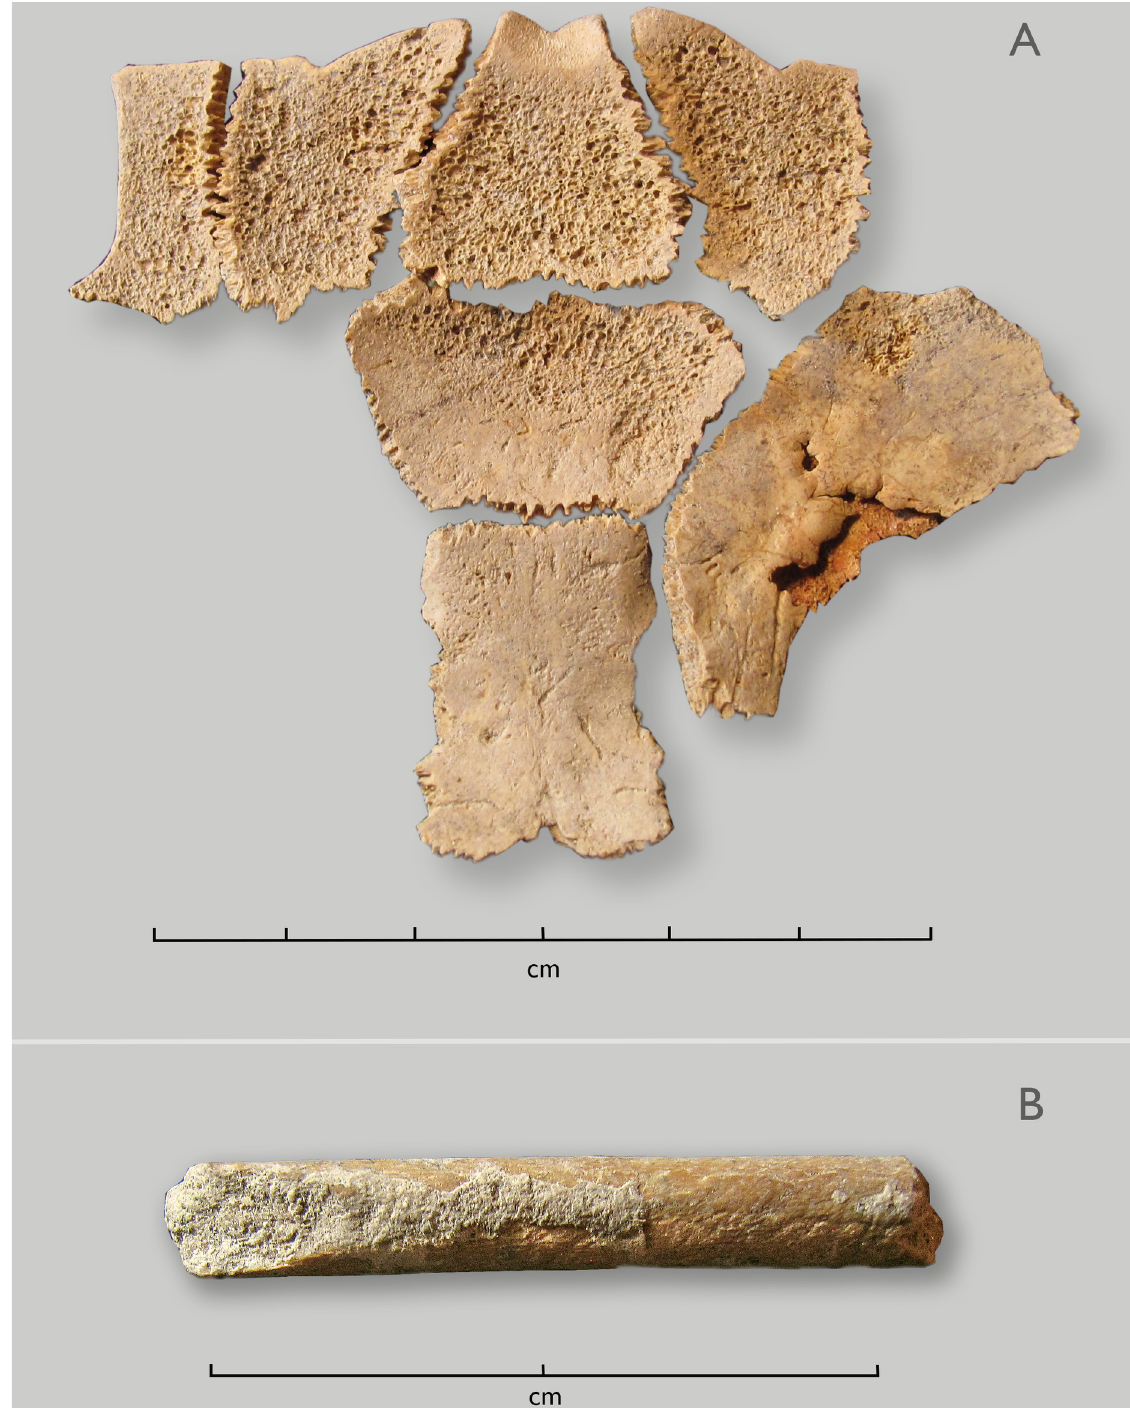
Fig 7. Artifacts from the “1997 unit”. A. Partial tortoise carapace bowl. B. Ground bone point or linkshaft, broken at both ends.